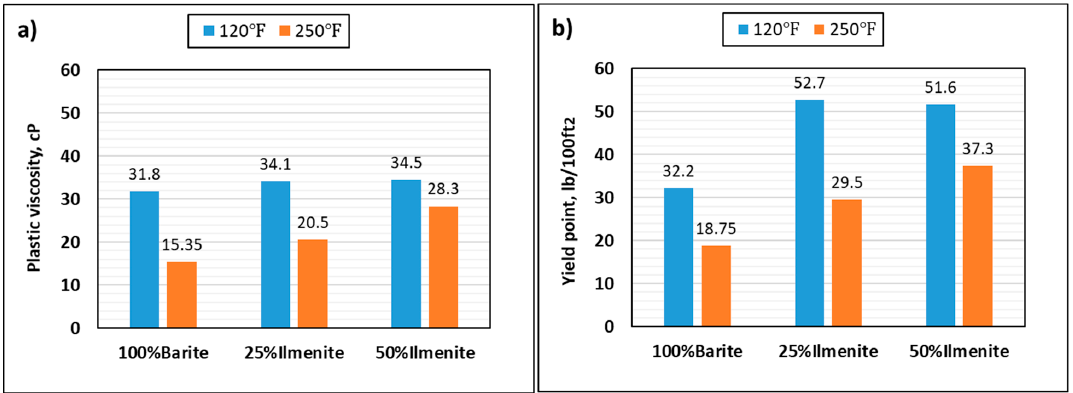
Figure 8. Effect of ilmenite on ( a ) plastic viscosity, and ( b ) yield point.